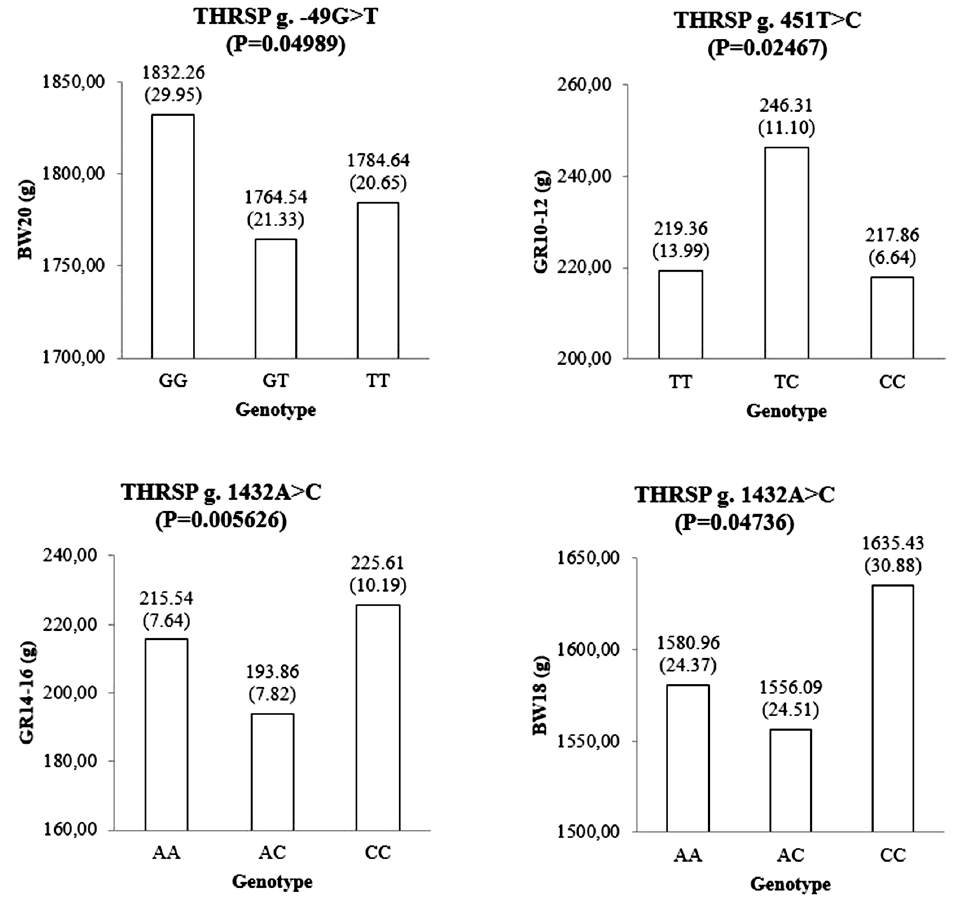
Figure 1. The genotypic means and standard errors of growth-related traits represent significant associations between the genotypes of the THRSP gene and growth- related traits. p values were calculated using a mixed-effects model analysis. BW00 is body weight at birth; BW02 is body weight at 2 weeks of age; BW04 is body weight at 4 weeks of age; BW06 is body weight at 6 weeks of age; BW08 is body weight at 8 weeks of age; BW10 is body weight at 10 weeks of age; BW12 is body weight at 12 weeks of age; BW14 is body weight at 14 weeks of age; BW16 is body weight at 16 weeks of age; BW18 is body weight at 18 weeks of age; BW20 is body weight at 20 weeks of age; GR0-2 is body weight gain at 0 to 2 weeks of age; GR2-4 is body weight gain at 2 to 4 weeks of age; GR4-6 is body weight gain at 4 to 6 weeks of age; GR6-8 is body weight gain at 6 to 8 weeks of age; GR8-10 is body weight gain at 8 to 10 weeks of age; GR10-12 is body weight gain at 10 to 12 weeks of age; GR12-14 is body weight gain at 12 to 14 weeks of age; GR14-16 is body weight gain at 14 to 16 weeks of age; GR16-18 is body weight gain at 16 to 18 weeks of age; GR18-20 is body weight gain at 18 to 20 weeks of